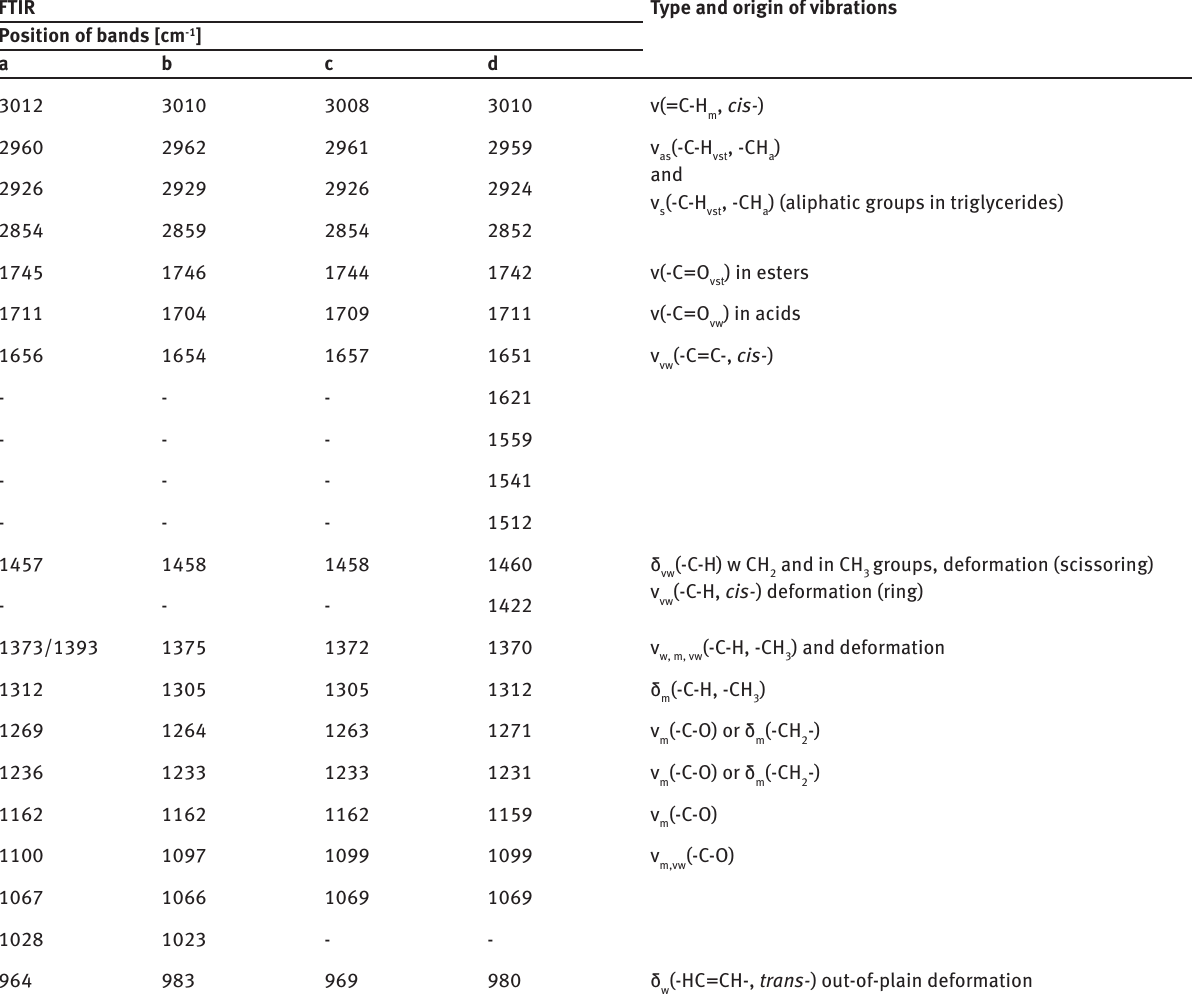
Table 2 : Positions of the maxima of absorption spectra and assignment to the relevant vibrations for Moldavian dragonhead oil samples stored at 23 o C (room temperature): a – immediately after pressing, b – two weeks after pressing, c – four weeks after pressing and d – 8 weeks after